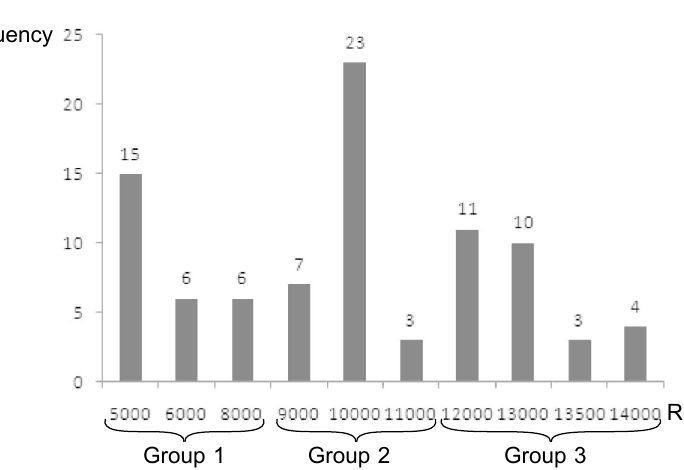
Group 1 Group 2 Group Figure 2. Grouping of similar properties based on rent intervals